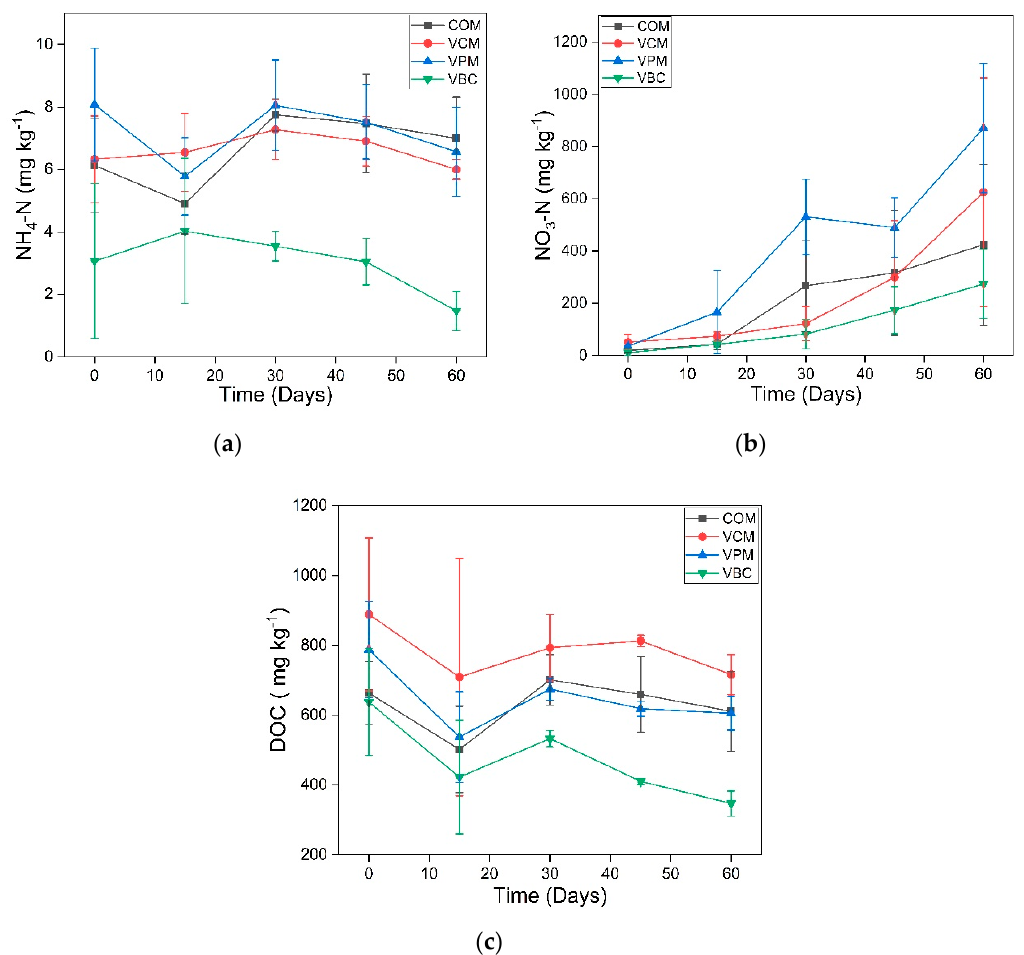
Figure 4. Mineral forms of nitrogen: NH 4 -N content ( a ), NO 3 -N content ( b ), and dissolved organic carbon ( c ) in all treatments as a mean of three replicates; error bars represent standard errors ( n = 3).